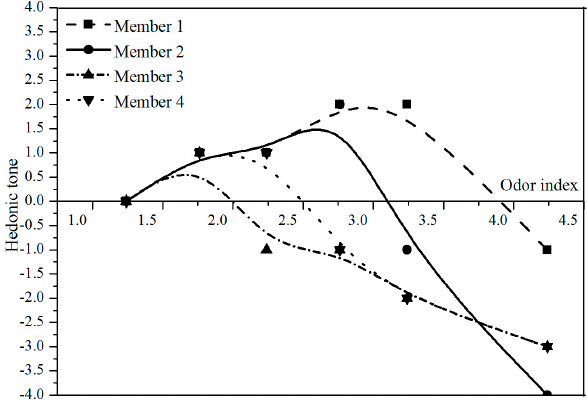
Figure 5. The behavior curves of individual members for butyl acetate.